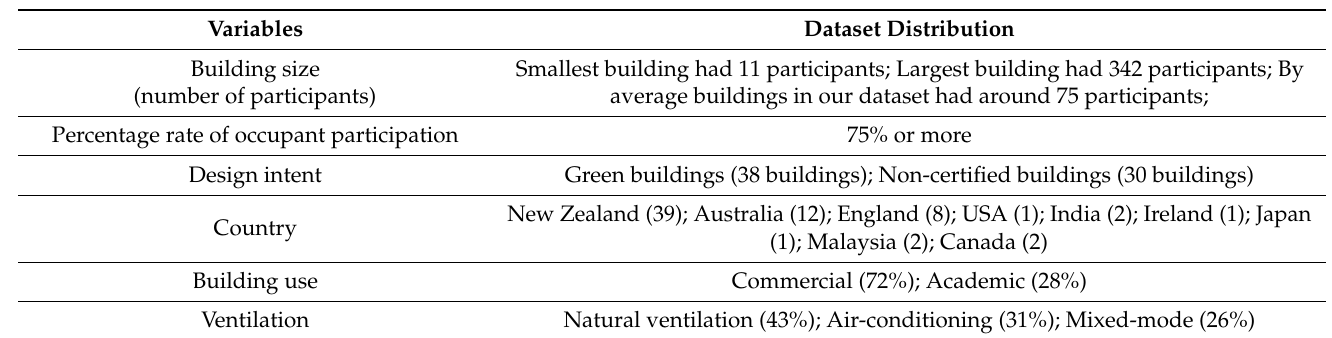
Table 2. Building specifications of the studied